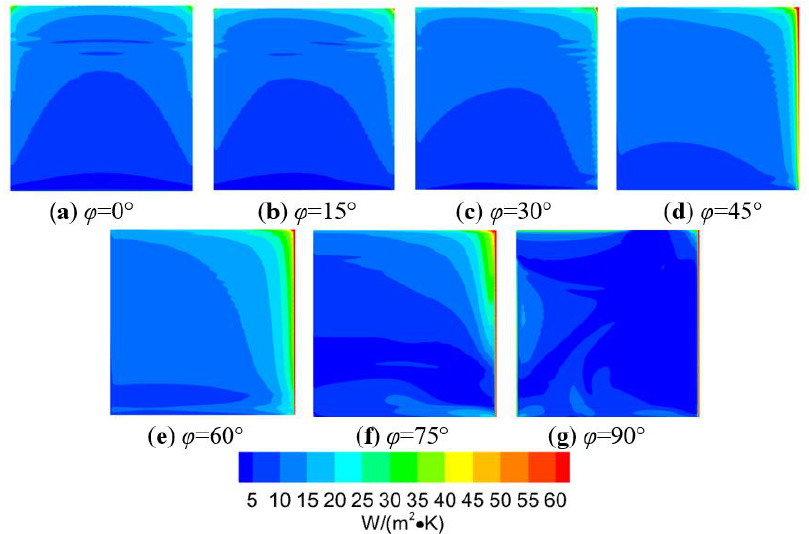
Figure Figure 9. The change in CHTC avg of the louvered façade with different wind directions ( U ref = 3.41 m/s, D = 0.05 H , B / H = 0.035, T H − T a = 10 °C, T B − T a = 20 °C, θ = 45°).